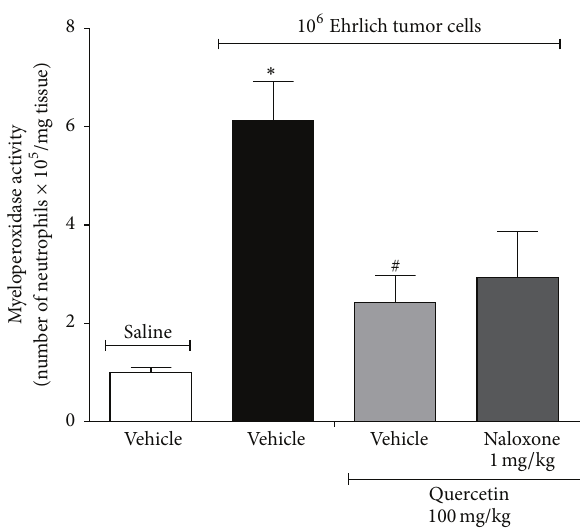
Figure 8: Naloxone did not reverse the effect of quercetin in reducing Ehrlich tumor cells-induced neutrophil recruitment. Mice were treated with quercetin (100mg/kg, i.p., starting 10 min after tumor administration) during 8 days after the injection of Ehrlich tumor cells (1 × 10 6 or 1 × 10 7 cells/25 𝜇 L) or saline and, in the 8th day, one group of mice that received quercetin was also treated with naloxone (1mg/kg i.p. diluted in saline) or its vehicle 1h before the treatment with quercetin. The neutrophil recruitment was evaluated in samples of paw skin collected after 3 h of the treatment with quercetin by the myeloperoxidase (MPO) activity assay. Data are presented as means ± SEM of six mice per group per experiment and representative of two separated experiments: ∗ 𝑝 < 0.05 compared to the saline group and # 𝑝 < 0.05 compared to the tumor group. One- way ANOVA followed by Tukey’s